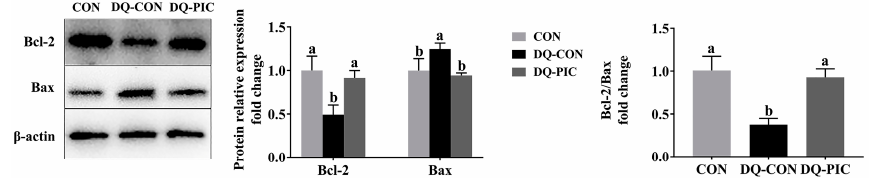
Figure 3. Effects of piceatannol supplementation on expression levels of protein related to apoptosis in the liver of diquat-induced piglets. The column and its bar represented the means value and SE ( n = 6), respectively. Bcl-2, B-cell lymphoma-2; Bax, Bcl2-associated x; CON, piglets were orally administrated vehicle solution (0.5% sodium carboxymethyl cellulose) and challenged with sterile saline; DQ-CON, piglets were orally administrated vehicle solution and challenged with diquat (10 mg / kg body weight); DQ-PIC, piglets were orally administrated piceatannol (80 mg / kg / day) and challenged with diquat (10 mg / kg body weight). a, b Di ff erent letters on the shoulder mark indicate significant di ff erences ( p <